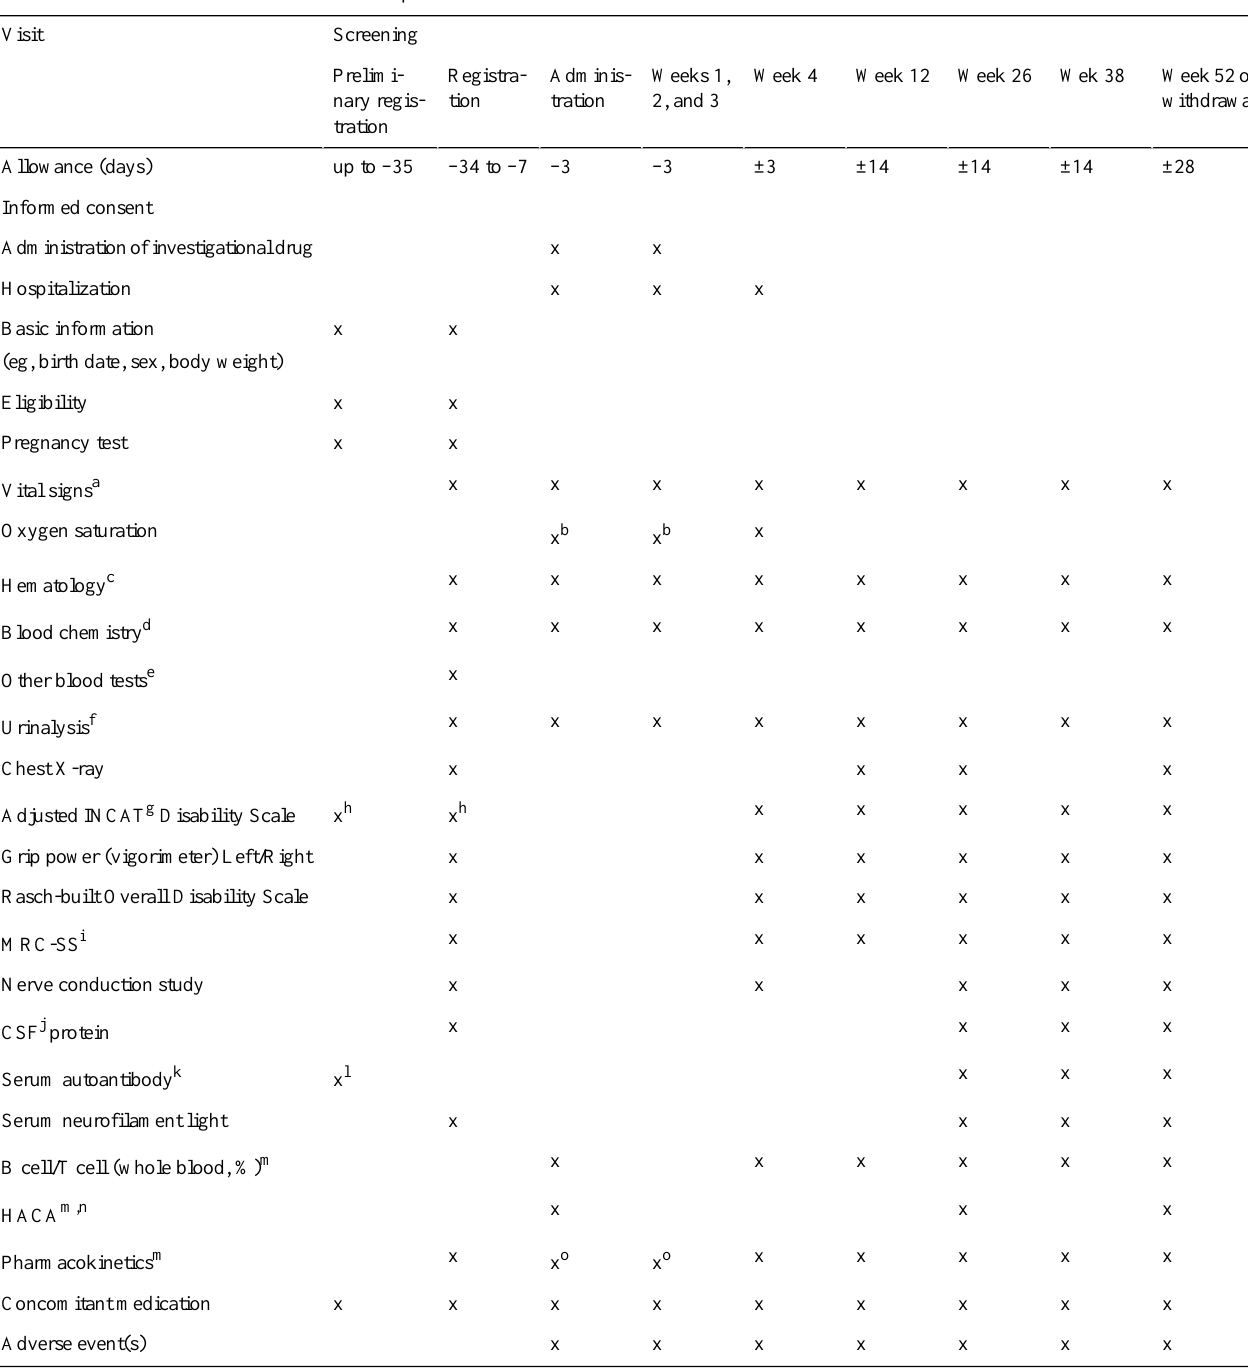
Table 1. Protocol for data collection from each patient enrolled in the RECIPE trial.